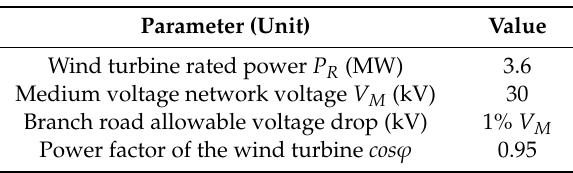
Table 1. Main electrical parameters.